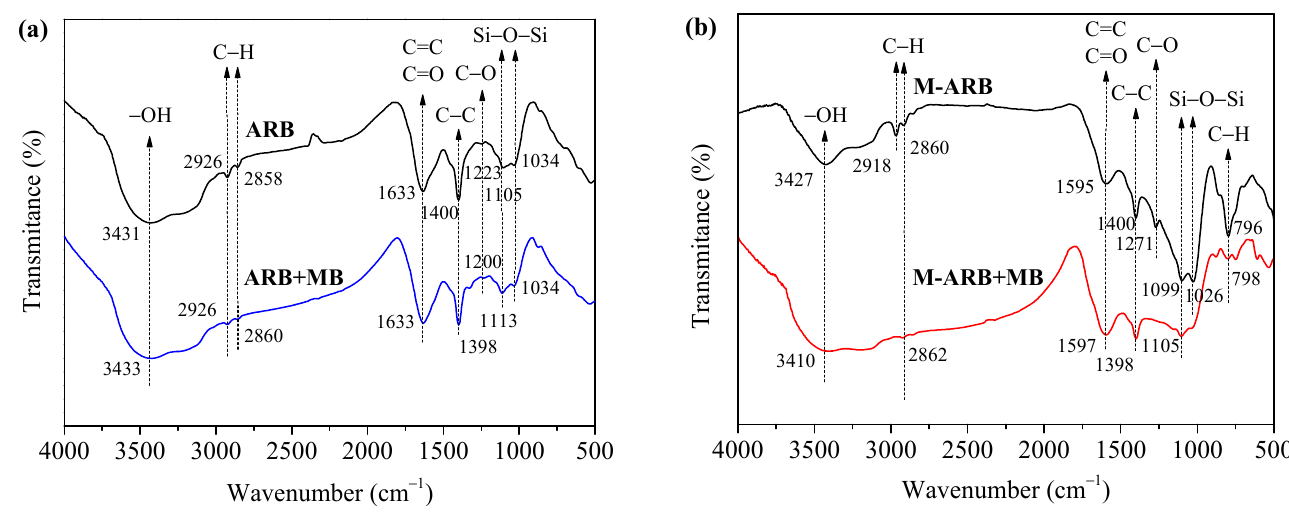
Figure 11. FTIR spectra of ARB ( a ) and M-ARB ( b ) before and after MB adsorption. The locations of the absorbance peak of several functional groups of ARB and M-ARB were changed to varying degrees after MB had been absorbed. Among them, the -OH absorption peaks of ARB and M-ARB were shifted to 3433 cm − 1 and 3410 cm − 1 , respectively. This has to do with the creation of hydrogen bonds between the biochar’s -OH and the heterocycles on MB that contain nitrogen; thus, hydrogen bonding had a significant impact on the adsorption [64,65]. The C-H stretching vibration peak of ARB at 2858 cm − 1 had been changed to 2860 cm − 1 , while the peak at 2926 cm − 1 had not. The C-H stretching vibration peak of M-ARB at 2860 cm − 1 was displaced to 2862 cm − 1 , while the peak at 2918 cm − 1 vanished. The C=O and C=C absorption peaks of ARB remained in their original locations, whereas M-ARB’s C=O and C=C absorption peaks changed to 1597 cm − 1 , implying the presence of π – π bonding between MB and NaOH-modified areca residue biochar [66]. However, this effect was weaker in the unmodified areca residue biochar and was not sufficient to change its absorption peak position. The C-C absorption peaks of both ARB and M-ARB were shifted to 1398 cm − 1 , indicating the involvement of C-C functional groups in the adsorption reaction. The C-O absorption peak of ARB moved to 1200 cm − 1 , while that of M-ARB disappeared. The Si-O-Si bending vibration peak of ARB at 1105 cm − 1 moved to 1113 cm − 1 , while the peak at 1034 cm − 1 was not offset. The Si-O-Si bending vibration peak of M-ARB at 1099 cm − 1 shifted to 1105 cm − 1 , while the peak at 1026 cm − 1 disappeared. In addition, following the adsorption of MB, the newly formed C-H bending vibration peak of M-ARB changed to 798 cm − 1 , demonstrating that C-H was also engaged in the adsorption reaction. This showed that the NaOH-modified areca residue biochar not only had a richer surface functional group structure, but also the type of functional groups involved in the adsorption reaction and the degree of participation had been enhanced, which enabled it to show better MB removal during adsorption [67]. The adsorption mechanism of ARB and M-ARB for MB in water is depicted in Figure